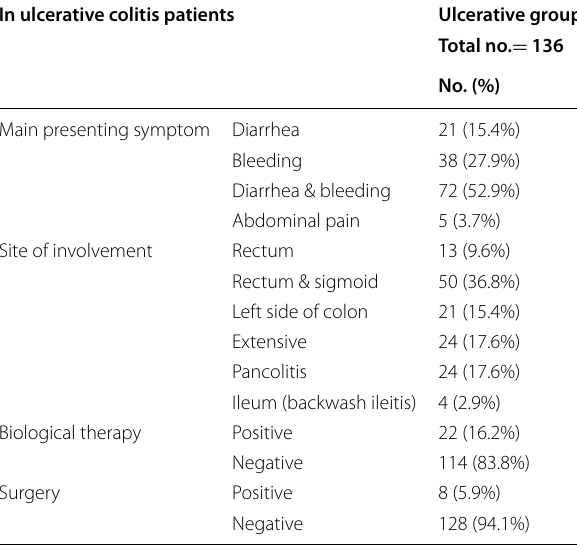
Table 9 Clinical characteristics of ulcerative colitis